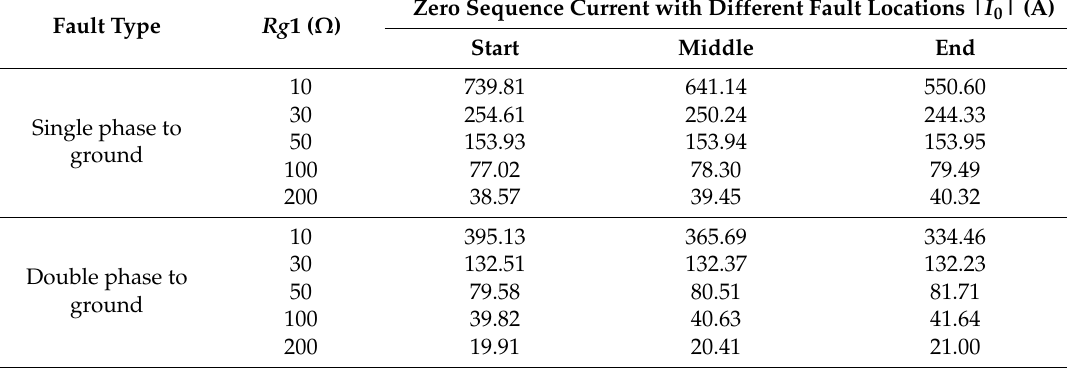
Table 4. Zero-sequence current values with the different fault location on the tie-line L3.